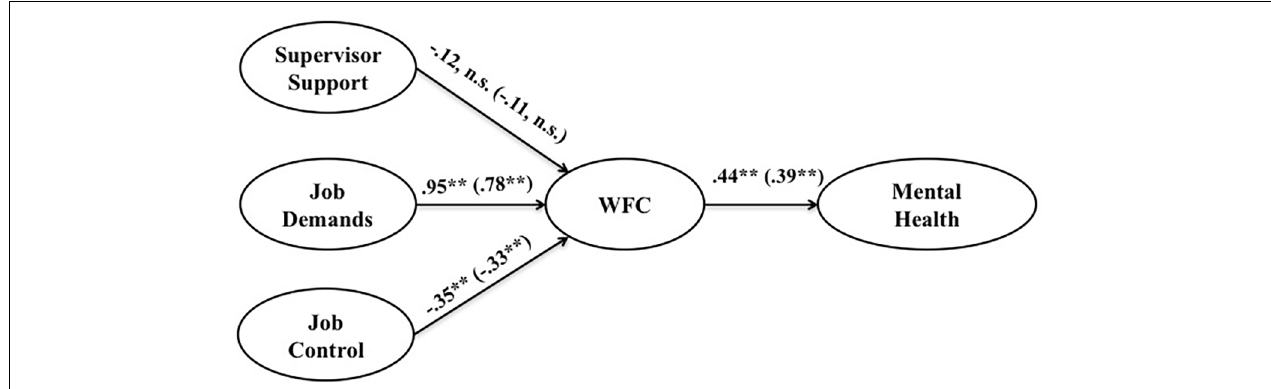
FIGURE 1 | Baseline unconstrained model ( N = 254). ∗∗ p < 0.01; ∗ p < 0.05; the values presented on the left side of the brackets refers to the females; the values presented within brackets refers to the